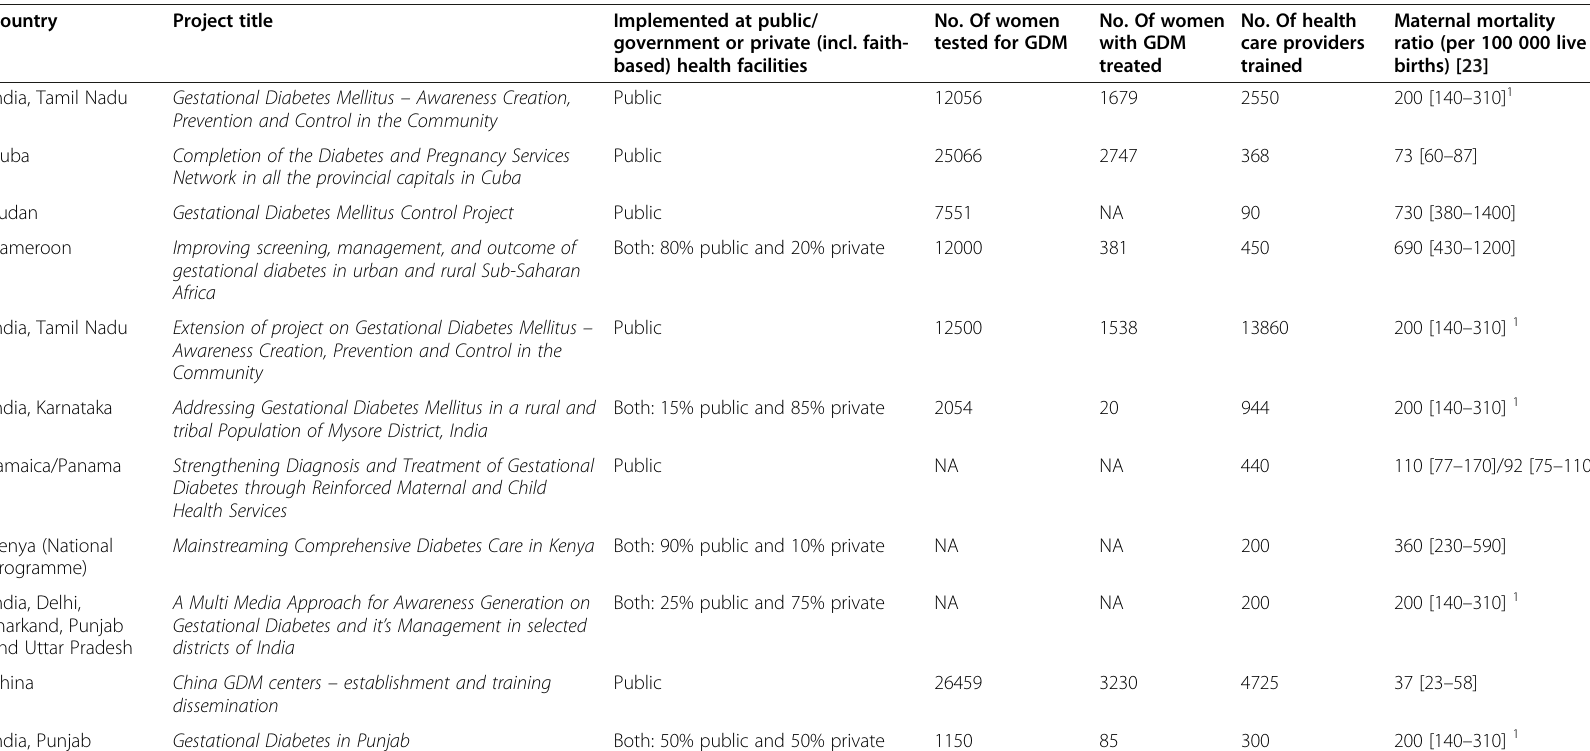
Table 2 Project achievements, details and country specific maternal mortality ratio